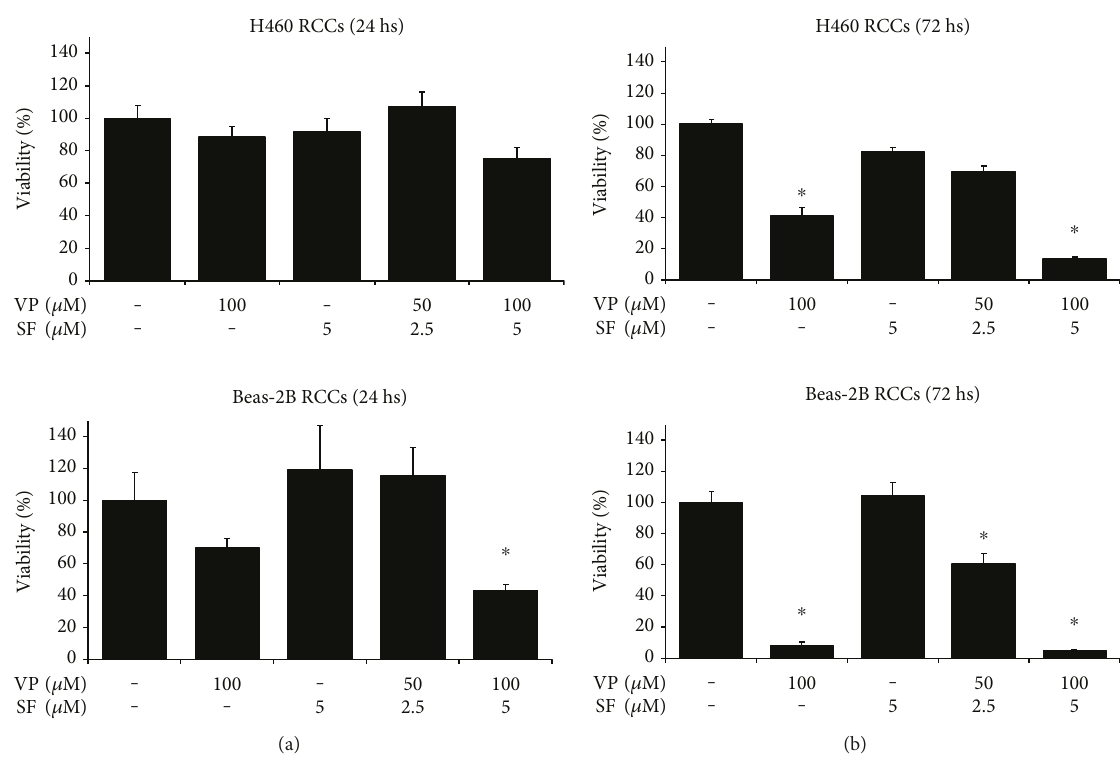
Figure 2: Cancer cells (H460) and the noncancerous cell line Beas-2B growing under RCCs are relatively resistant to short-term exposure to VP in combination with SF. Cells growing under RCCs were incubated with the indicated concentrations of VP and SF alone or in combination for 24 h (a) or 72 h (b). Cell viability was measured by the MTT assay. Results ( X ± SD) are representative of two independent experiments performed in sextuplicate. ∗ indicates P < 0 01